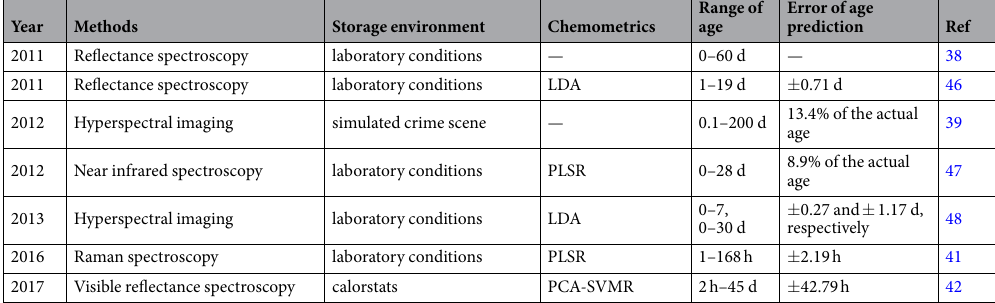
Table 1. Summary of spectroscopy techniques proposed for the age determination of